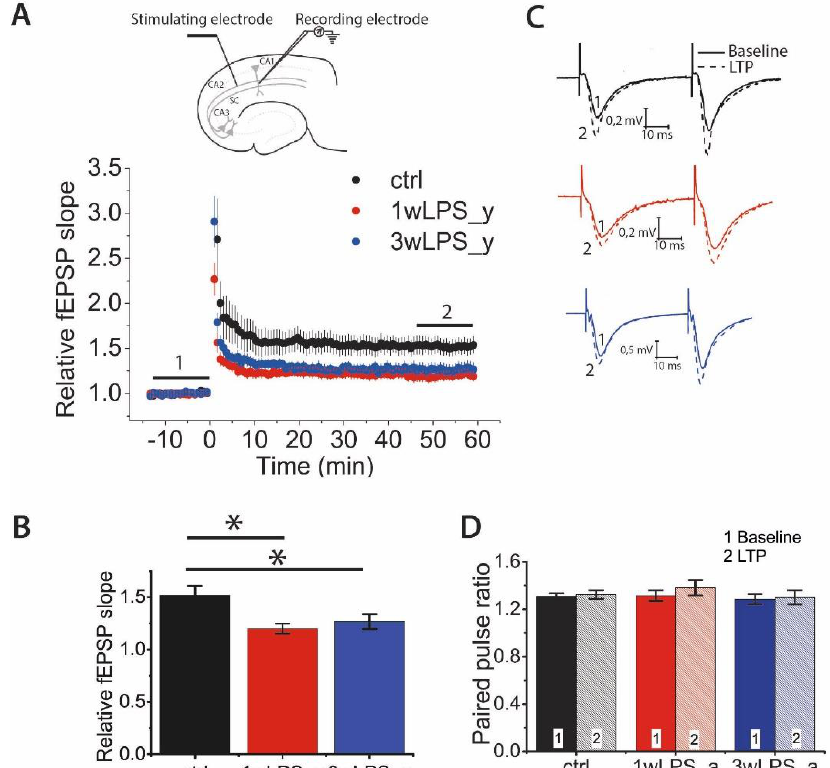
Figure 1. Hippocampal long-term potentiation (LTP) in young rats is weakened after the administration of lipopolysaccharide (LPS) in early postnatal ontogenesis. ( A ) The normalized field excitatory postsynaptic potentials (fEPSP) slope after theta-burst stimulation (TBS) in control (ctrl) and experimental animals injected with LPS during the first (1wLPS_y) or third (3wLPS_y) postnatal week. The insert (above) shows the positions of electrodes in the hippocampus. ( B ) Diagram illustrating the difference in LTP values between control and experimental animals (one-way ANOVA: F 2,48 = 3.30; p < 0.05; the significant difference with the control group: * p < 0.05). ( C ) Representative examples of paired fEPSP responses before (1) and after (2) TBS in control and experimental animals. ( D ) The paired-pulse ratio (PPR) of the fEPSP amplitudes before and after the induction protocol did not change in either control or experimental rats. Repeated measures ANOVA: F 2,49 = 2.53; p = 0.09 (control, n = 14; 1wLPS_y, n = 18; 3wLPS_y, n =